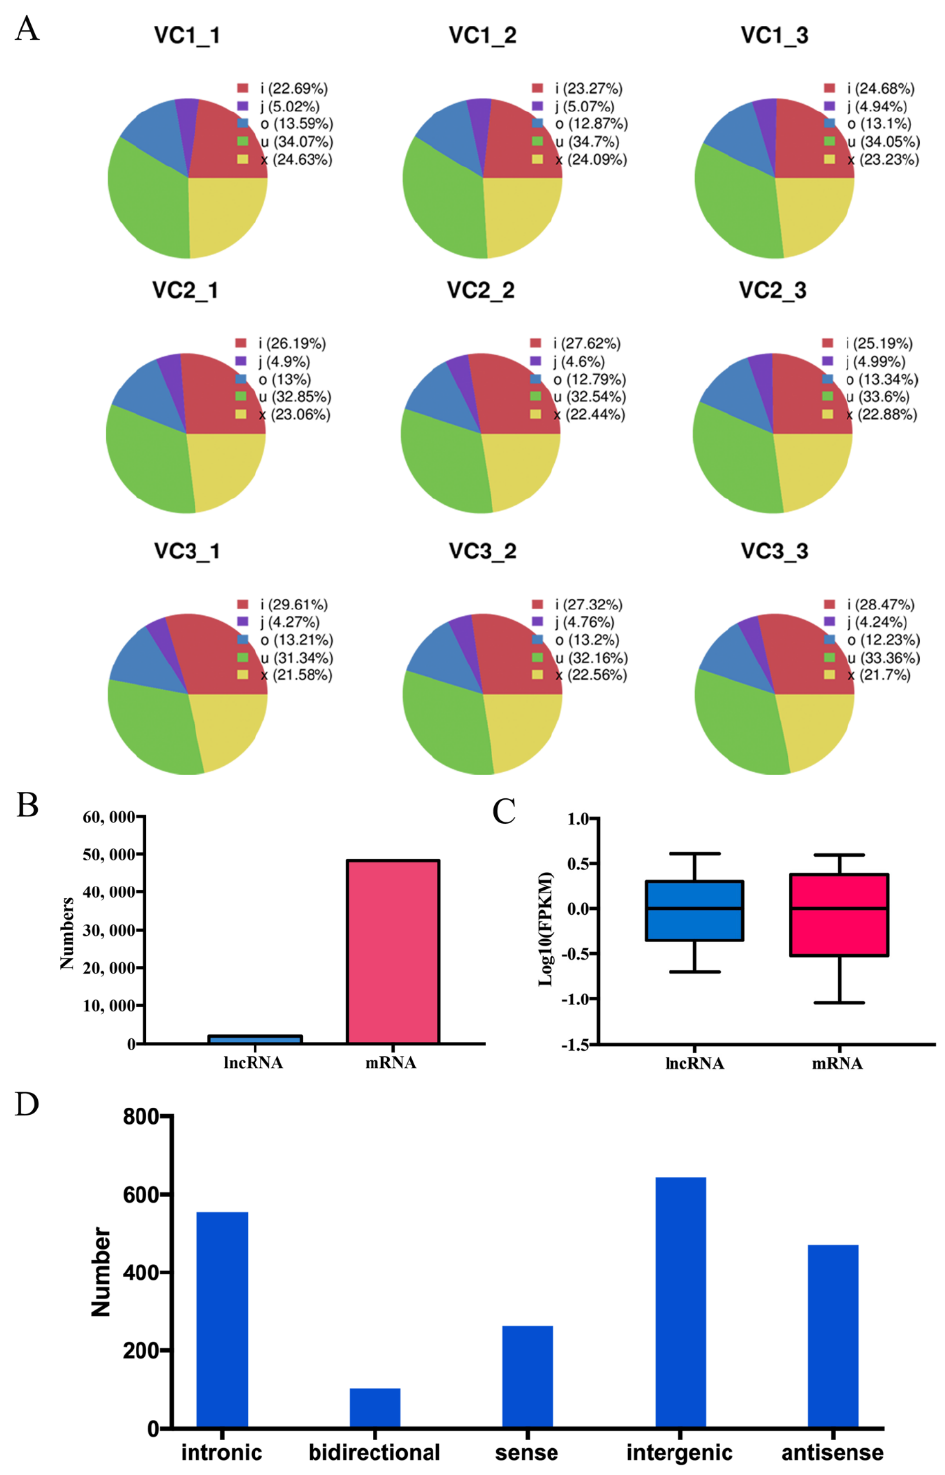
Figure 3. Characteristics of the non-coding RNAs. ( A ) Distribution of six types of lncRNAs. Known lncRNAs as for class code “=, with orange”), intronic lncRNAs as for class code “i, with light green”, lncRNAs share with reference at least one splice junction as for class code, with dark green, lncRNA of generic exonic overlap with a reference transcript as for class code “o, with blue”, lncRNA as for class code “u, with violet” and antisense lncRNA as for class code “x, with pink”. ( B ) Expression numbers of the mRNA-lncRNA expression. ( C ) Expression levels lncRNAs and mRNAs. ( D )